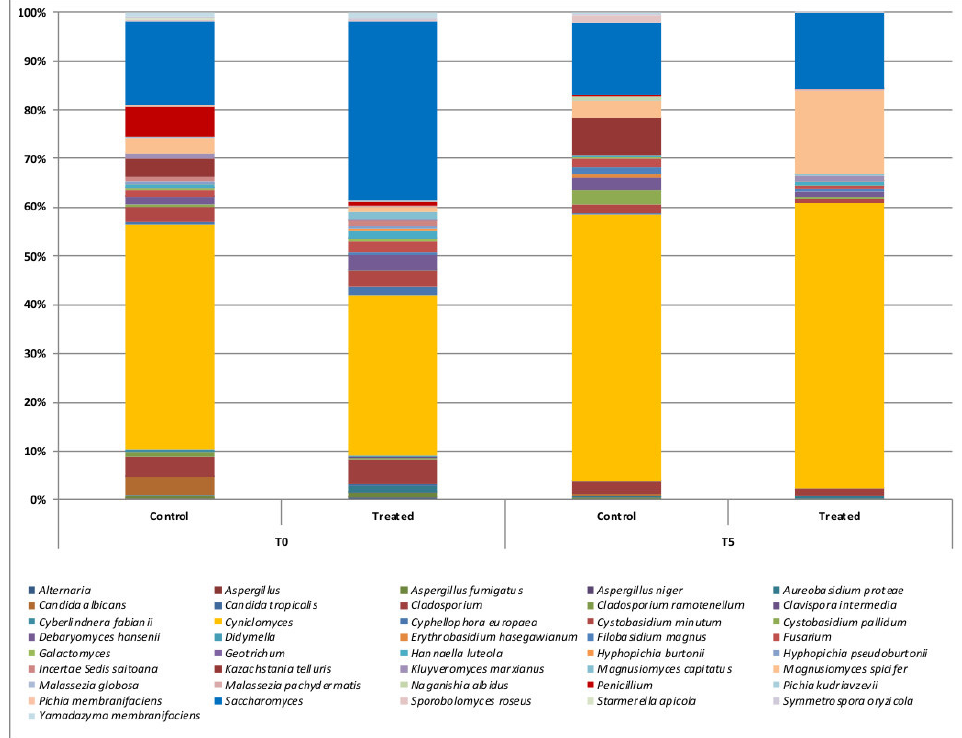
Figure 5. Relative frequency of the main fungal ASVs in fecal samples of dogs fed with control (C) or probiotic during the trial. Graph bars indicate the average of 15 fecal samples of dogs as replicate per each sampling point.